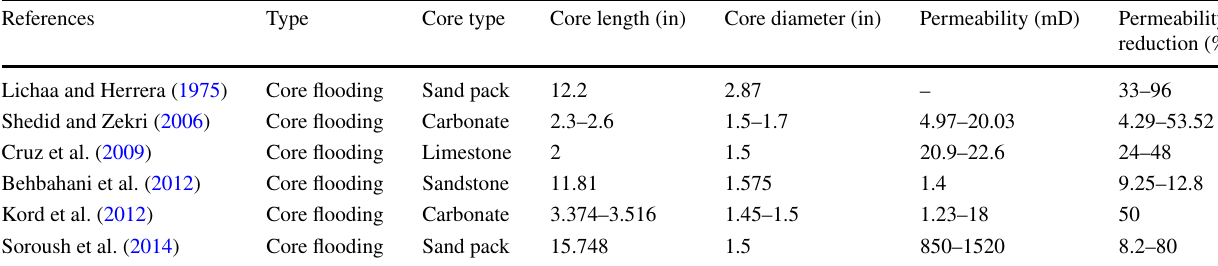
Table 7 Asphaltene permeability reduction values for different studies